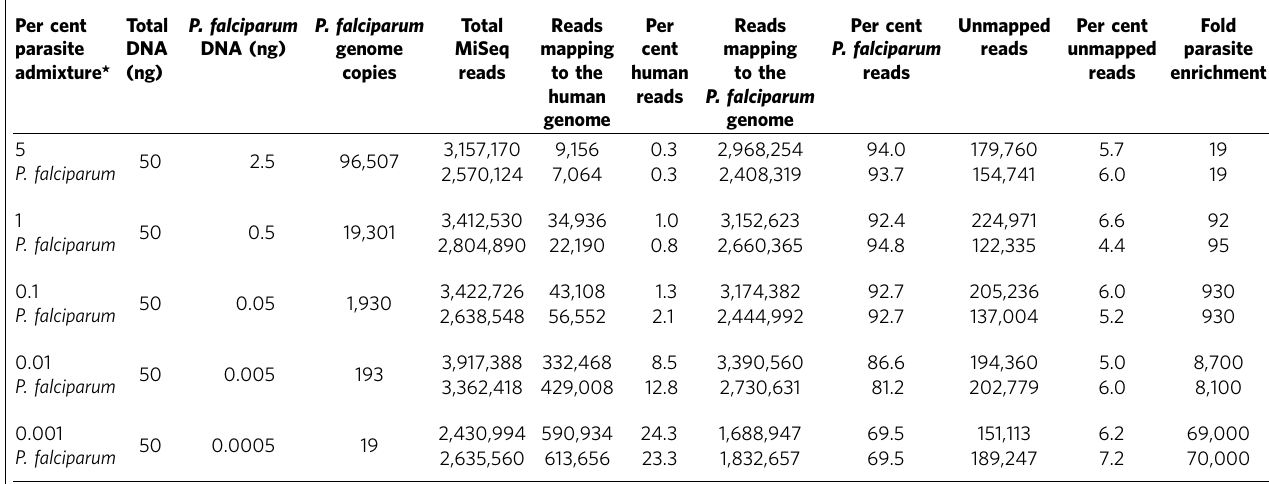
Table 1 | Selective whole-genome amplification of P. falciparum from mixtures of human and parasite DNA. Per cent parasite